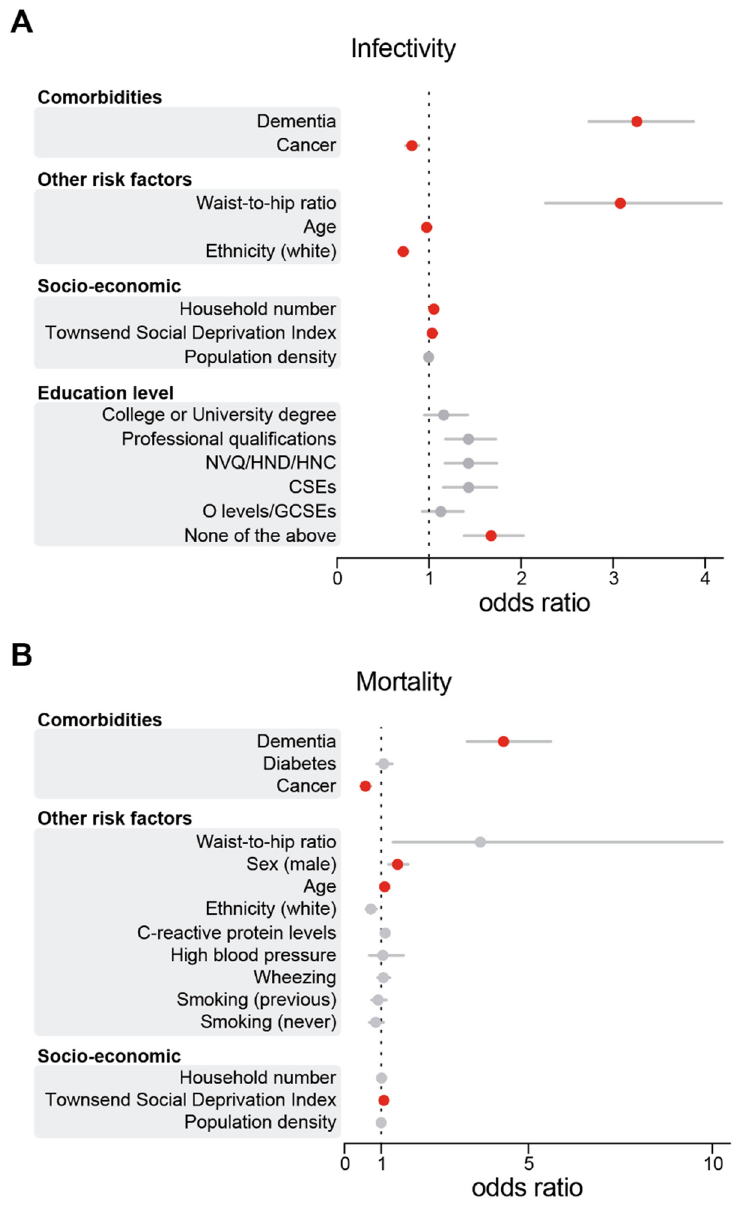
Figure 2. Dementia was the largest risk factor for SARS-CoV-2 infectivity and death. Odds ratios and their respective 95% CIs for the relationship between individual-level characteristics and COVID-19 cases ( A ) or deaths ( B ). For simplicity, characteristics were subgrouped into three categories, namely, ‘comorbidities’, ‘other risk factors’ and ‘socio-economic’. Red indicates significant associations ( p ≤ 0.05), while grey indicates a lack of significance ( p > 0.05). The odds ratios for education levels are relative to A-levels. NVQ/HND/HNC, participants who received vocational qualifications such as National Vocational Qualifications (NVQ), Higher National Certificate (HNC) or Higher National Diploma (HND); CSEs, participants with a Certificate of Secondary Education (CSEs); O-levels/GCSEs, participants with either a General Certificate of Secondary Education (GCSE) or a General Certificate of Education (GCE) Ordinary Level (O-levels), a secondary school leaving qualification. This figure is related to Supplementary Tables S3 and S4.